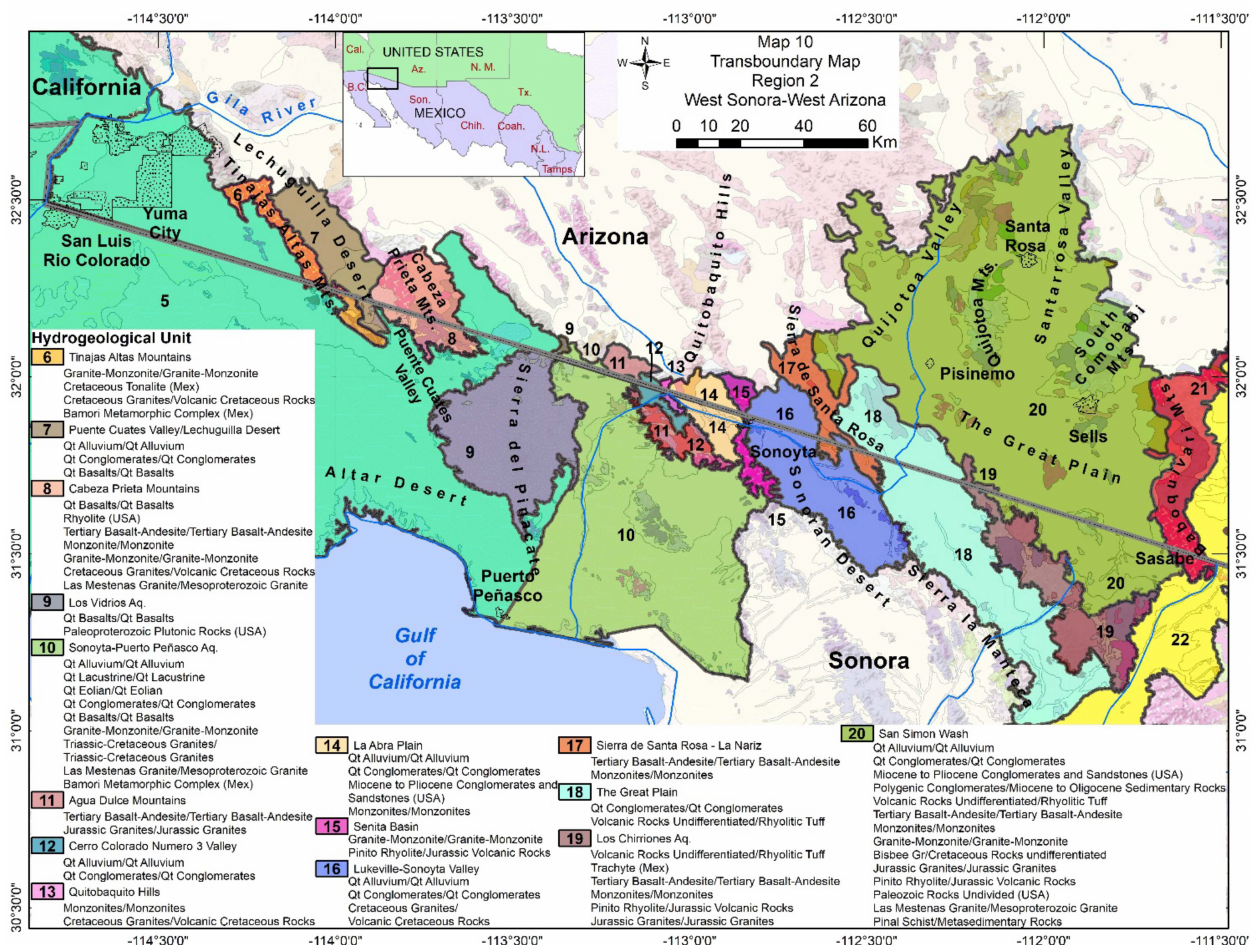
Figure 10. Transboundary map, West Sonora—West